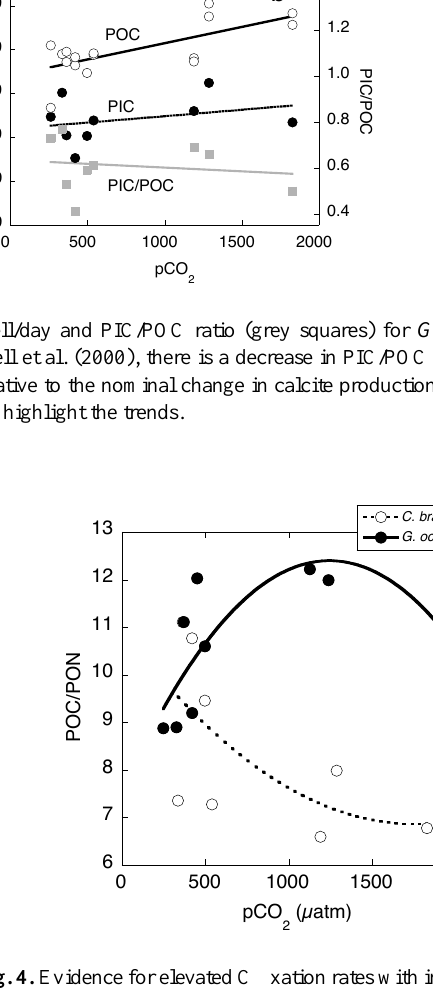
Fig. 4. Evidence for elevated C fixation rates with increasing p CO 2 in G. oceanica (black circles) arises from elevated POC/PON ratios with increasing p CO 2 . By contrast, C. braarudii (open circles) ap- pears detrimentally affected, showing a decrease in POC/PON with increasing p CO 2